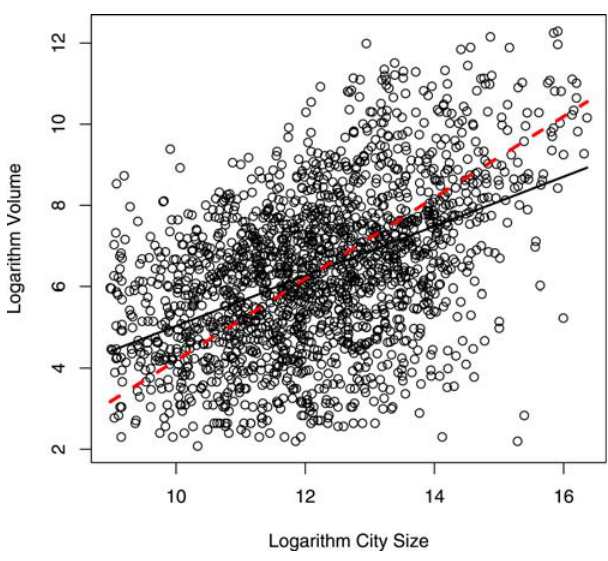
Figure 2. Log-log relation between the city and flight volume size in the data. Ordinary regression is represented with a solid black line, while an orthogonal regression is a dashed red. Orthogonal regression minimizes the orthogonal distance from the regression line as opposed to minimizing vertical distance in ordinary regression. The spread of the residuals is comparable to the range of the data indicating high variation of the flight volume for cities of the similar sizes. Orthogonal regression provides a useful reference line because it treats flight volume and city size as equal variables and could be viewed as the principle component capturing the essence of the relationship between the two variables. At the same time ordinary regression considers flight volume as a function of the city size. The lower slope in the regression line compared to the orthogonal regression indicates that there are many large cities that have a small flight volume as well as small cities with high flight volume.